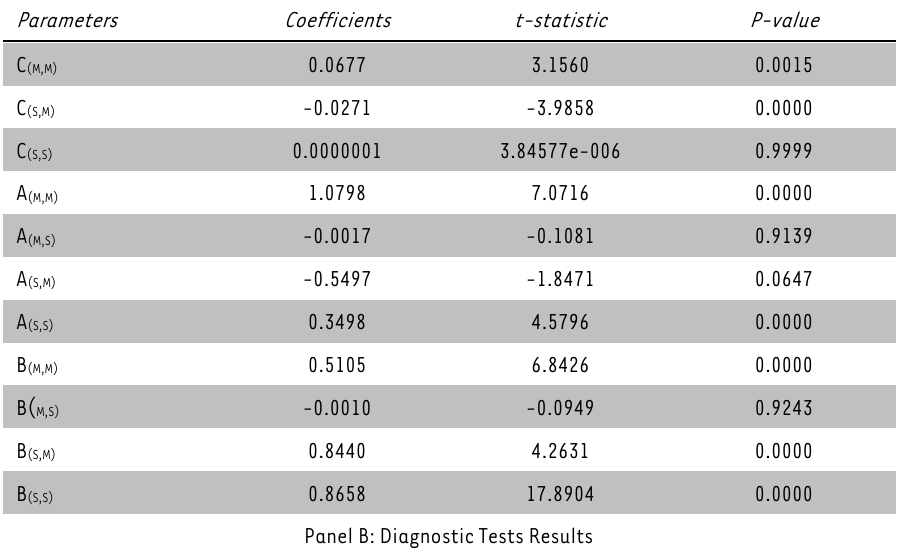
TABLE 4: Estimated Results of the GARCH-BEKK Model Parameters